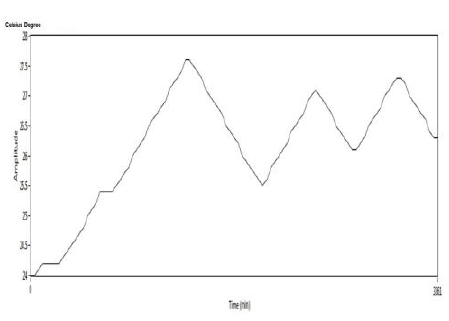
Figure 17. Temperature data stored by wired SHT11 digital sensor.